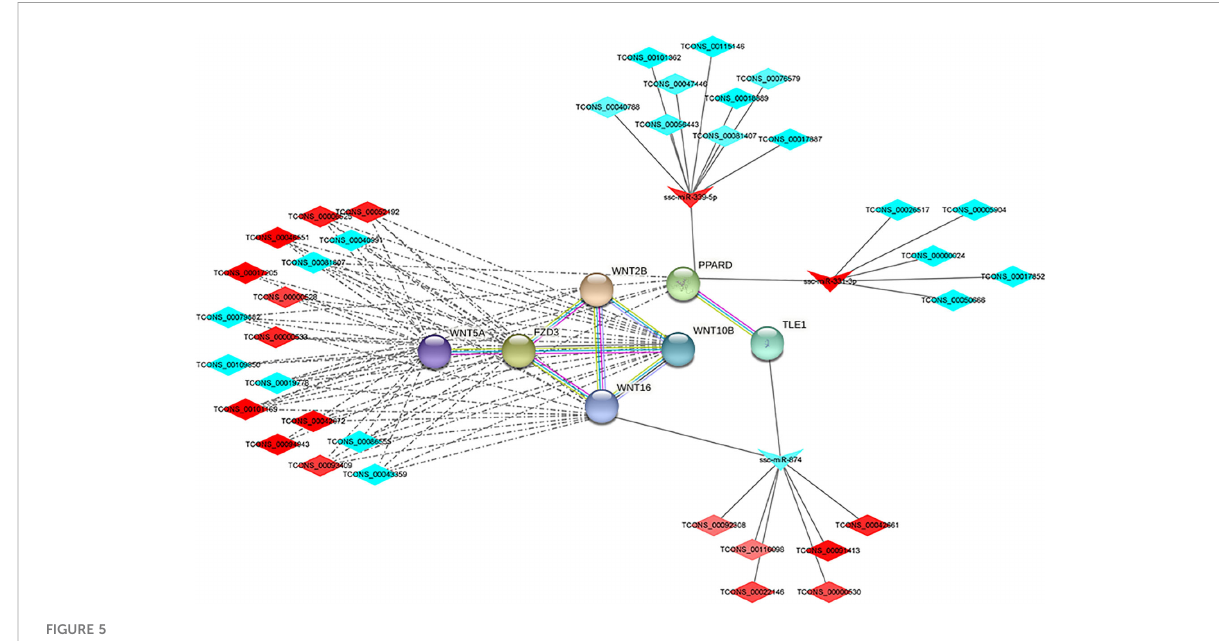
FIGURE 5 Regulatory network of Wnt signaling